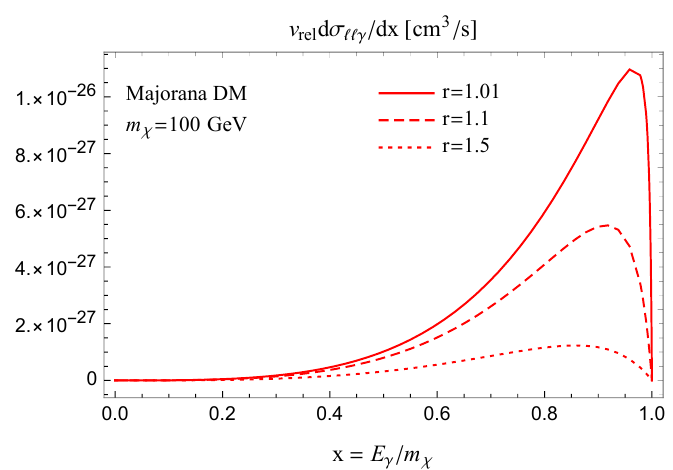
Figure 5 . Photon spectrum from (cid:31) (cid:22) (cid:31) ‘ (cid:22) ‘(cid:13) in the Majorana DM model. Here, the DM mass ! is m (cid:31) = 100 GeV and r = m =m (cid:31) and the portal Yukawa coupling is unity. The spectrum is e L completely the same for the scalar